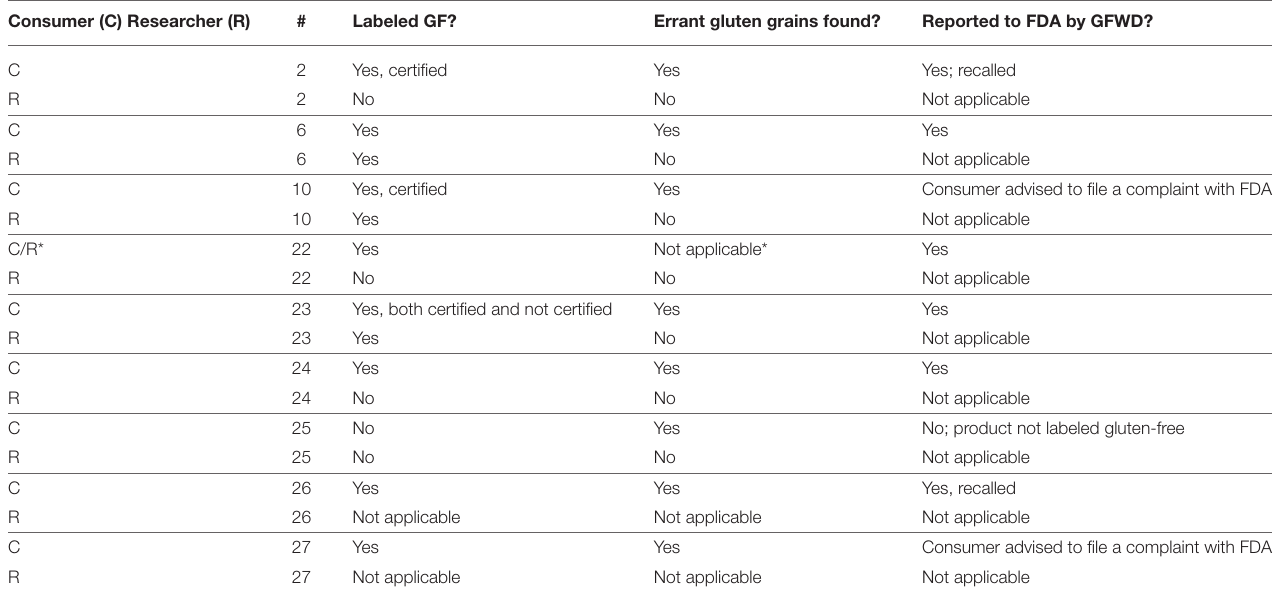
TABLE 2 | Errant gluten-containing grain findings and labeling language changes in 2021 as compared to dry lentil brands reported by consumers between 2016 and 2020. Consumer (C) Researcher